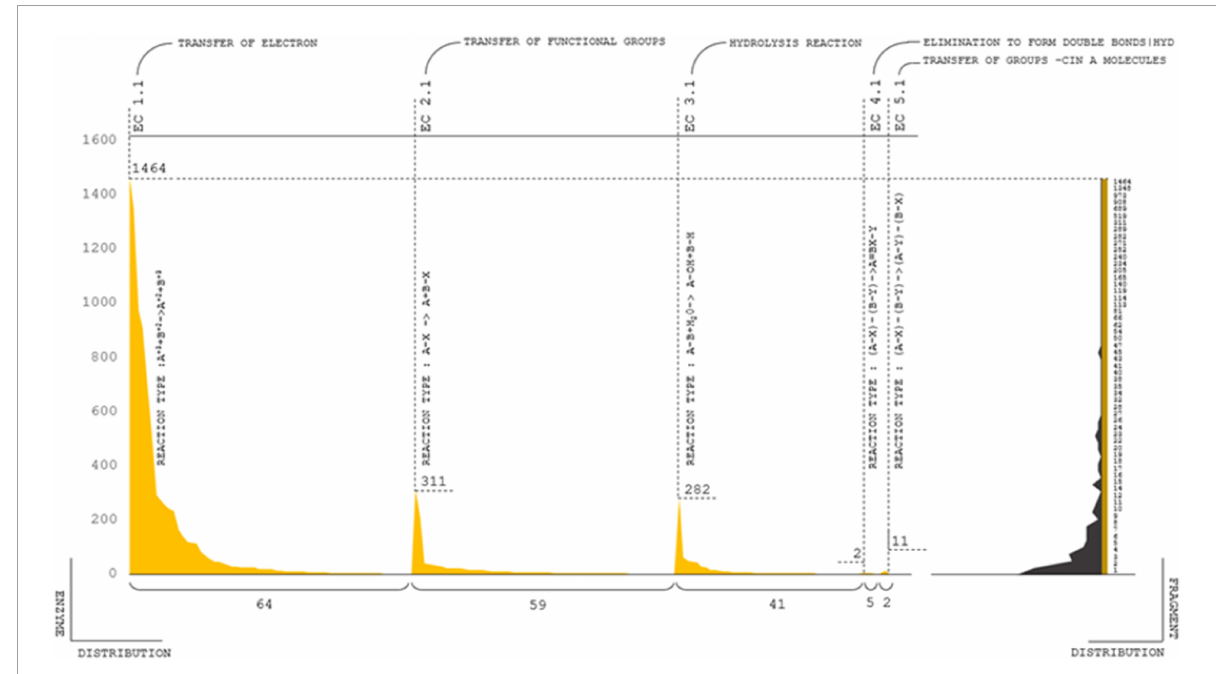
FIGURE6 Annotated Genes of Vigna umbellate shared between Vigna angularis and Vigna radiata